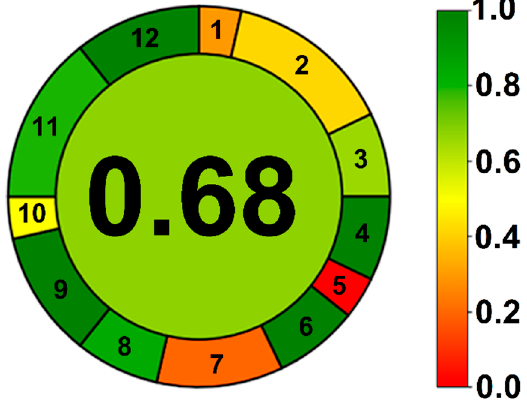
Figure 9. Pictogram showing the result of assessment and color scale. Adapted from Ref. [78]. x.